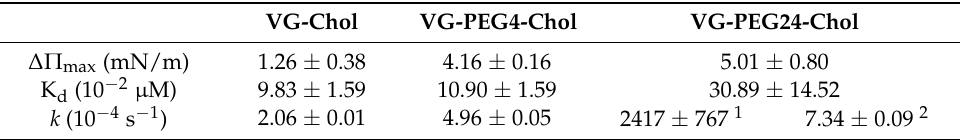
Figure 1. Surface pressure perturbation of lipid monolayers. ( A ) Changes in the surface pressure as a function of concentration of VG peptides (or DMSO) added to POPC:Chol 2:1 monolayers. ( B ) Maximum surface pressure perturbation achieved at 0.63 µ M of peptide (dashed line in A) or DMSO. ( C ) Variation of the surface pressure of POPC:Chol 2:1 monolayers as a function of time after injection of VG peptides at a final concentration of 0.2 µ M. C1 is a section of the first 100 s of the kinetic assay showing the two-phase behavior of VG-PEG24-Chol, characterized by a fast membrane insertion during the first 20 s ( a ), followed by a slower interaction over time ( b ). Table 2. Peptide-lipid monolayer interaction parameters. The data from Figure 1A were fitted using Equation 1, yielding the maximum surface pressure change, ∆Π max , and the dissociation constant, K d , values presented here. The data on variation of the surface pressure of POPC:Chol 2:1 monolayer as a function of time after injection of VG peptides at a final concentration of 0.2 µ M (Figure 1C) were fitted with Equation 2, permitting the calculation of the kinetic adsorption rate constant, k . Values are means ± standard error of the mean (SEM) of at least 3 experiments.